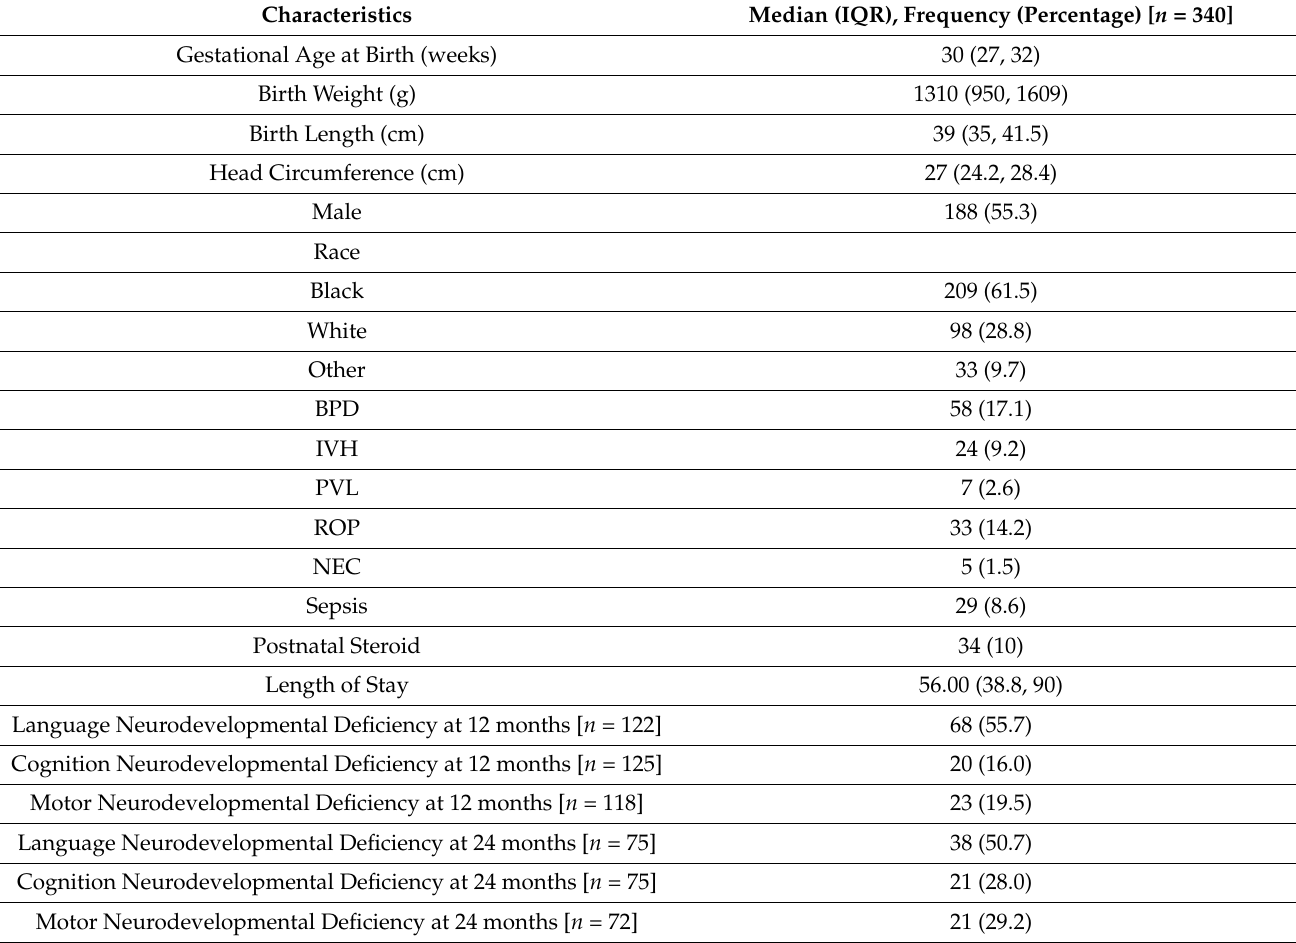
Table 1. Demographic and clinical characteristics of study population.